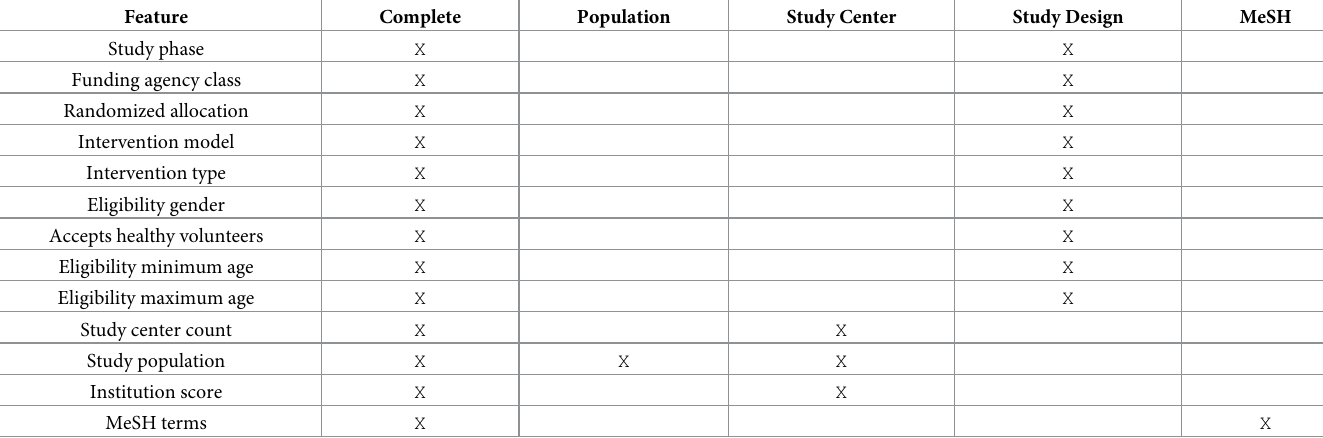
Table 2. The feature sets used for information content